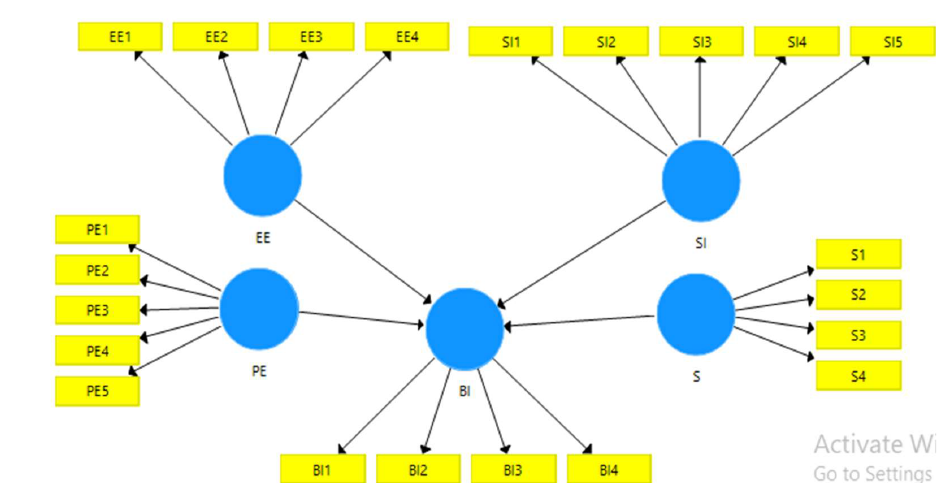
Fig. 1. Research Model by